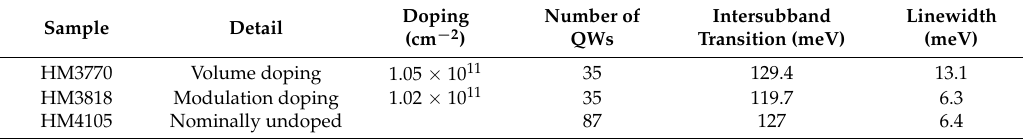
Table 1. The first set of samples for studying the broadening mechanism of ionized impurities.